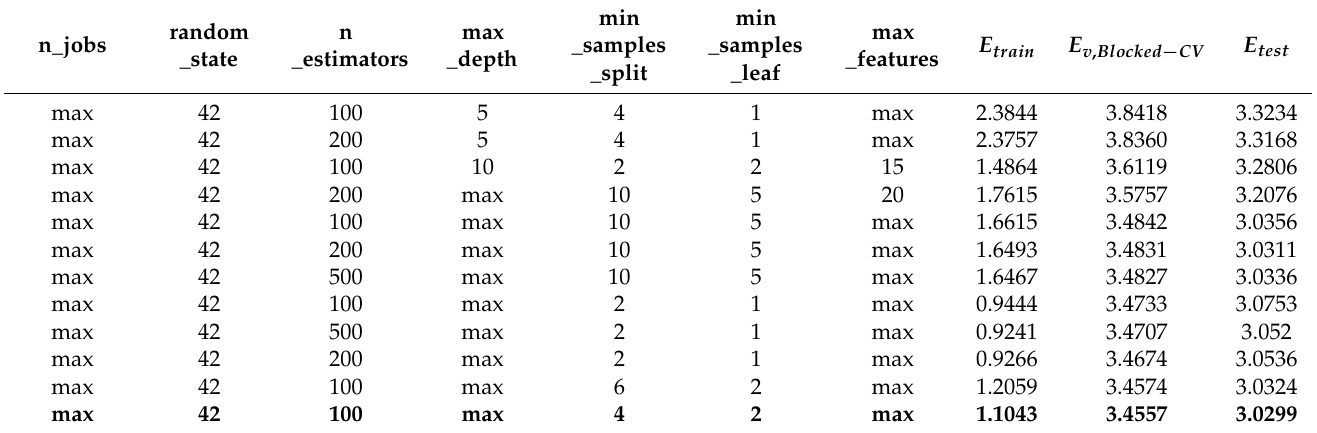
Table A4. Hyper-parameter tuning of the RF model (Group 1).